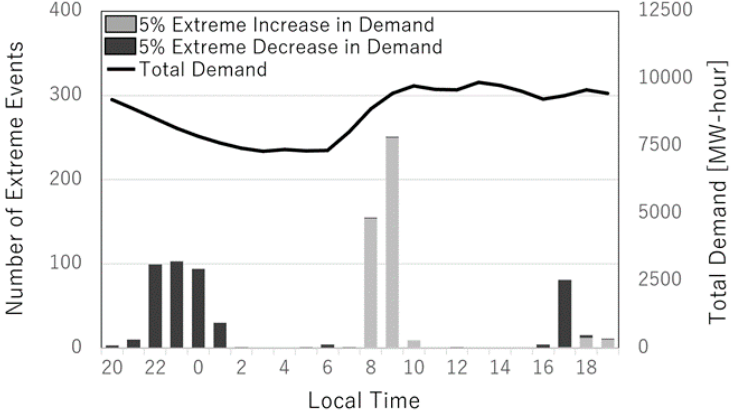
Figure 13. Sub-daily variation of extreme increase and decrease events in the energy demand. The bar graphs represent 5% of the extreme changes in demand of energy events binned within their respective hours. The line graph shows the annual mean hourly energy demand.